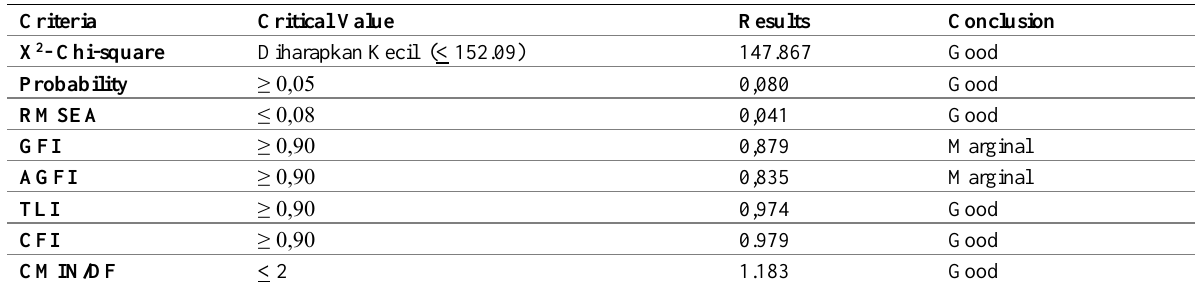
Table 5 : Goodness of Fit Model Test